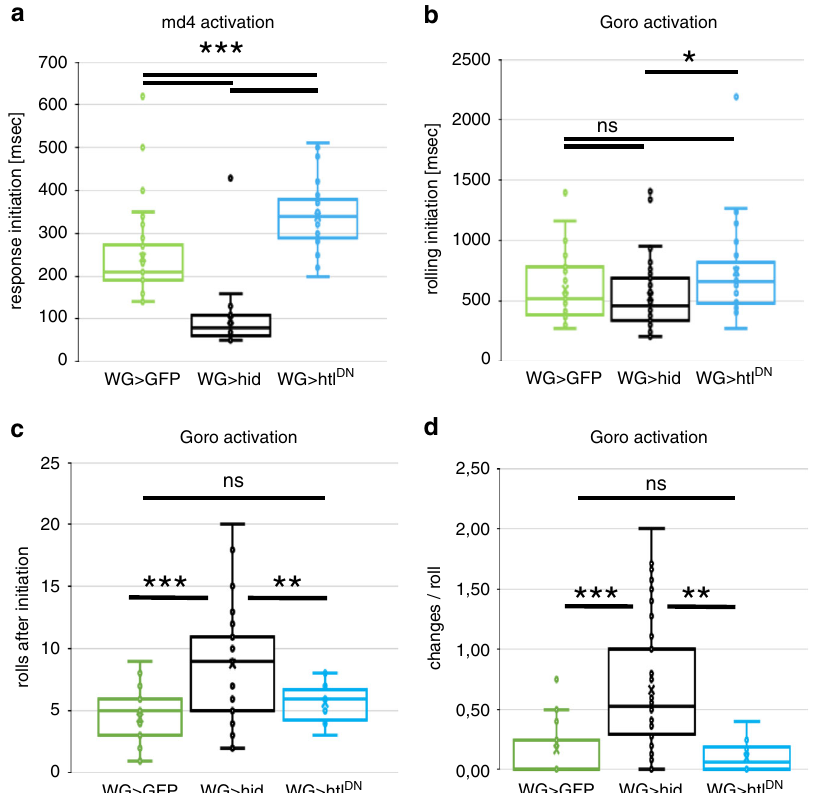
Fig. 10 Modulation of the Goro circuit. a Upon optogenetic activation of the mdIV neurons in third instar control larvae [ ppk-LexA, nrv2-Gal4/UAS-GFP; LexAop-csChrimson, nrv2-Gal4/90C03-Gal80 ] rolling is induced after 210 ms ( n = 38 larvae). Upon ablation of the wrapping glia in third instar larvae [ ppk- LexA, nrv2-Gal4/UAS-hid; LexAop-csChrimson, nrv2-Gal4/90C03-Gal80 ] no rolling response is induced but larvae cramp after 80 ms ( n = 28 larvae; p = 7E